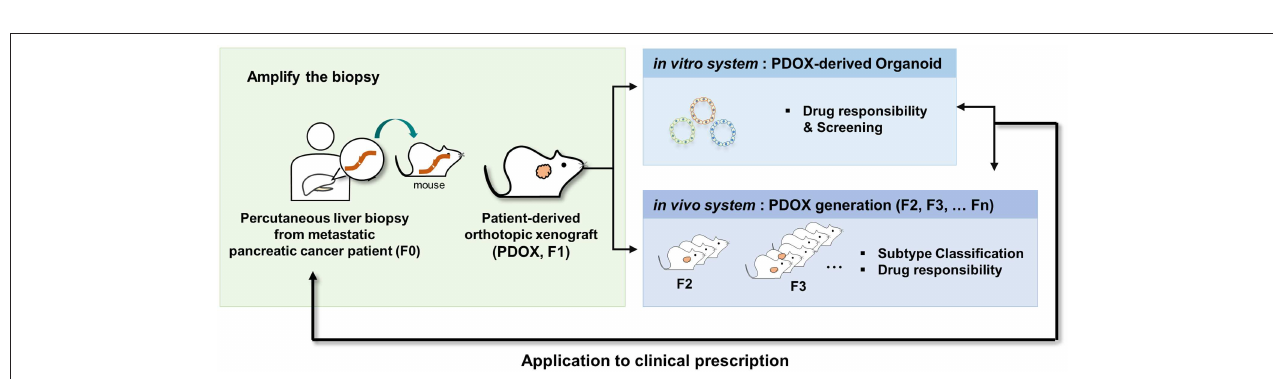
FIGURE 6 | Schematic description of the overall platform for the establishment and utilization of pancreatic cancer PDOX and PDOX-derived organoids. Step 1, establishment of PDOX from a percutaneous liver biopsy of a patient with metastatic pancreatic cancer; step 2A, expansion and dissection of the molecular features of the PDOXs; step 2B, screening of candidate anticancer drugs using organoids from PDOXs; step 3, selective drug response of PDOX models; step 4, clinical